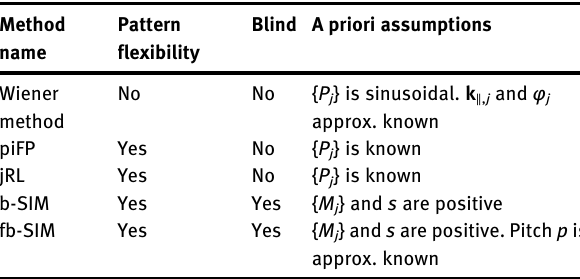
Table  : Studied reconstruction algorithms with their speci fi c